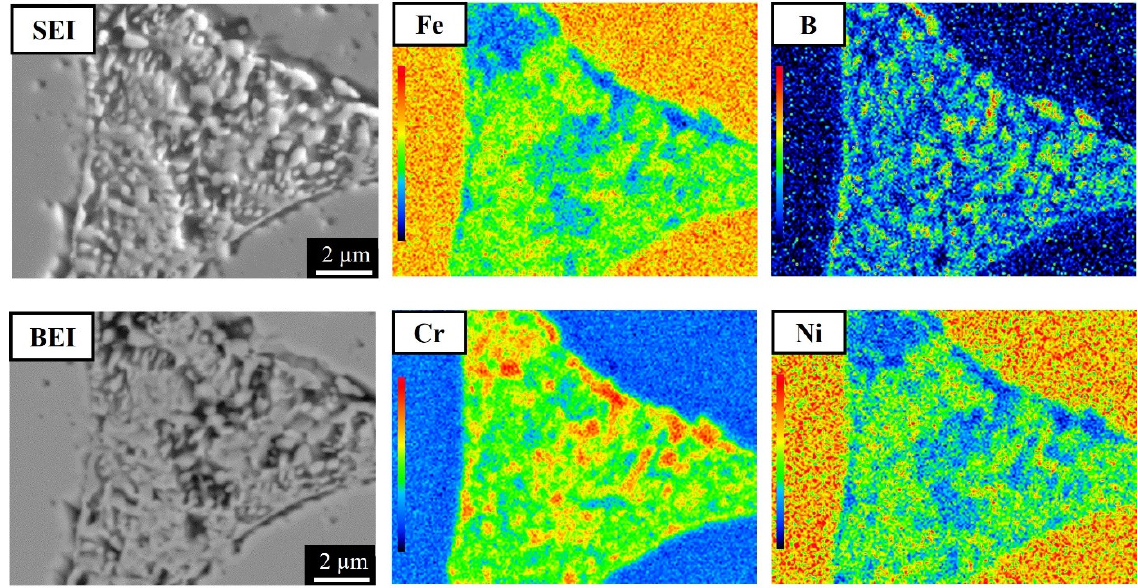
Figure 6. EPMA elemental distributions of 304L + 0.6B steel sintered at 1250 °C for 1 h in vacuum.